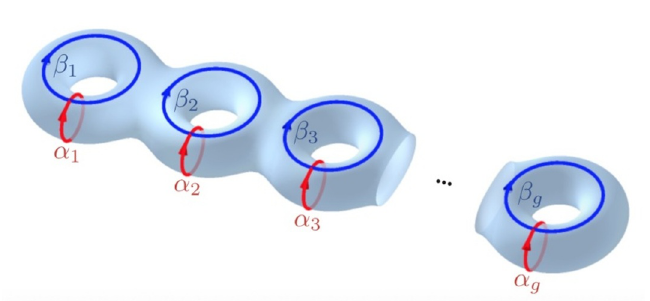
Figure 3 . The canonical homology basis for (cid:6) g .